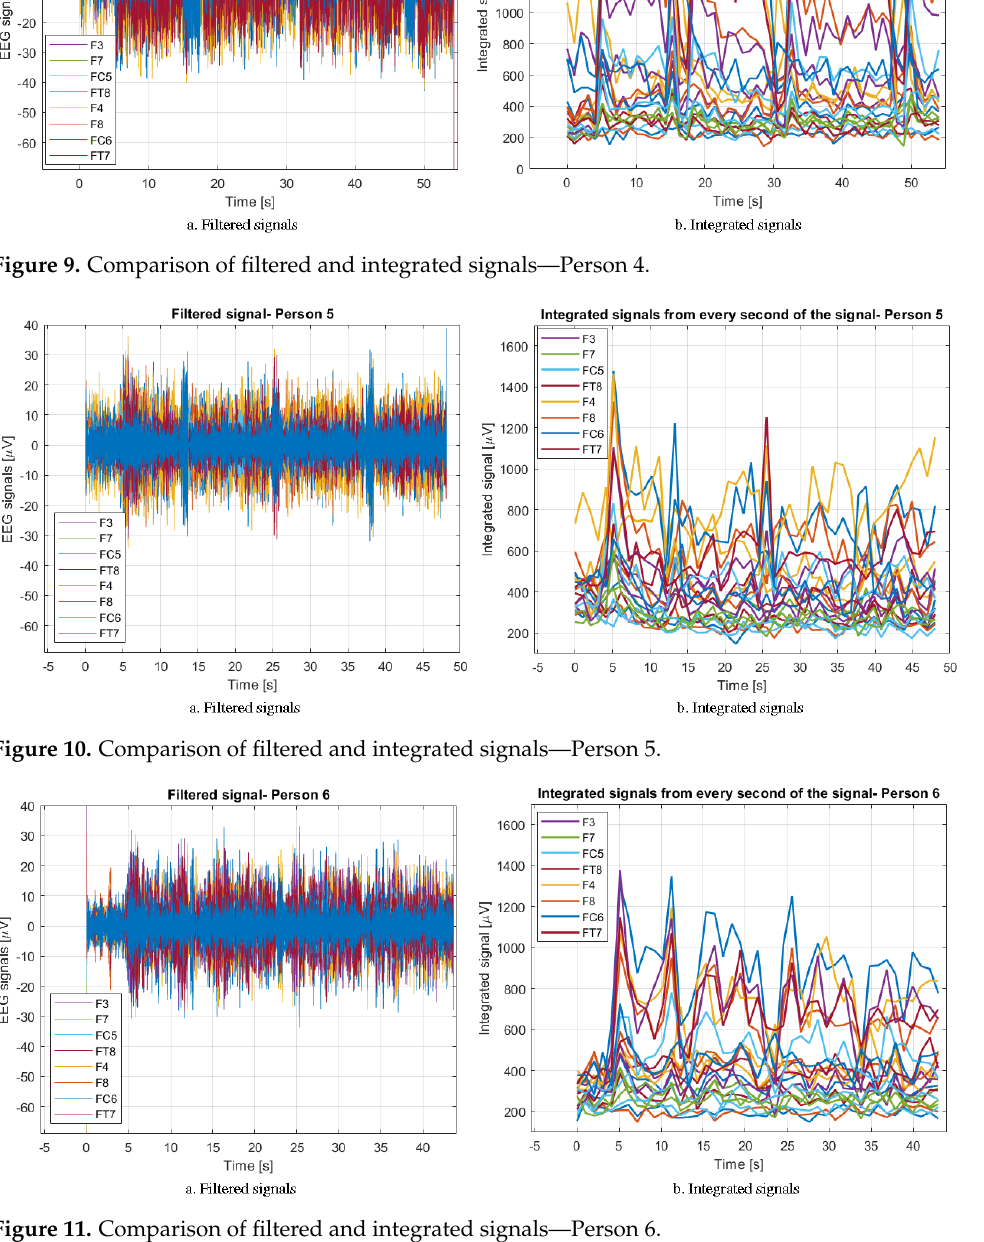
Figure 11. Comparison of filtered and integrated signals—Person